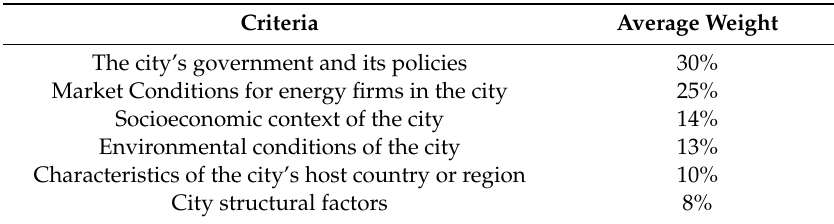
Table 3. Aggregated criteria weights, obtained from AHP.